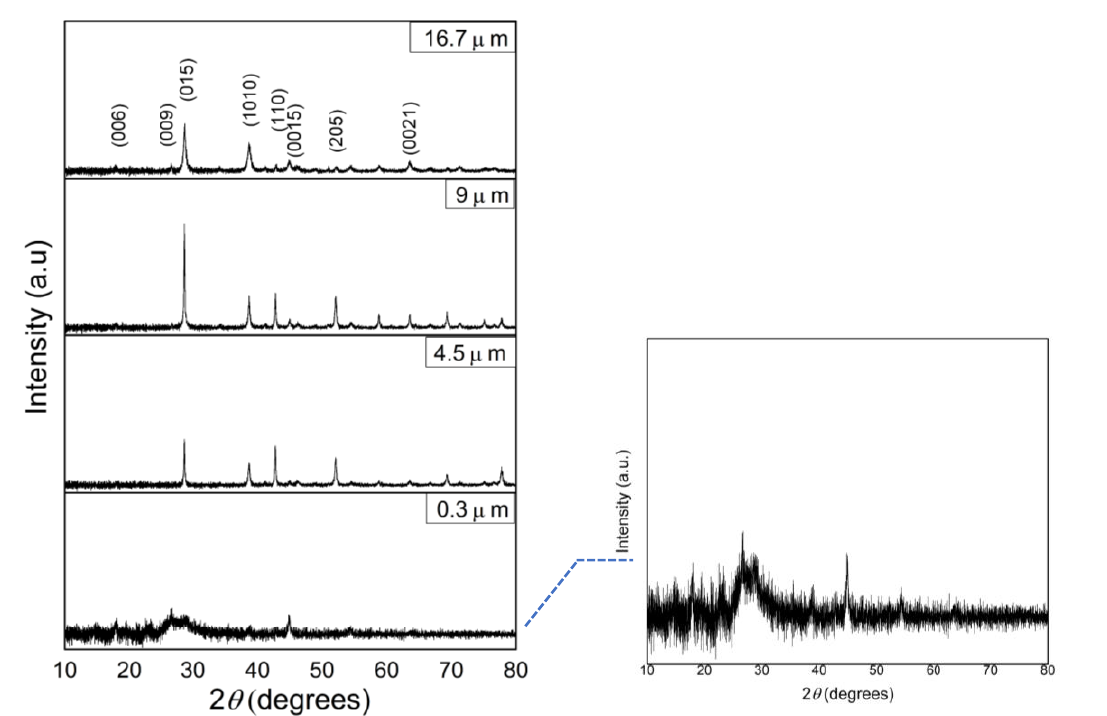
Figure 3. XRD patterns of deposited Sb 2 Te 3 films with different film thicknesses. The inset shows the rescaled pattern of film thickness of 0.3 µm.